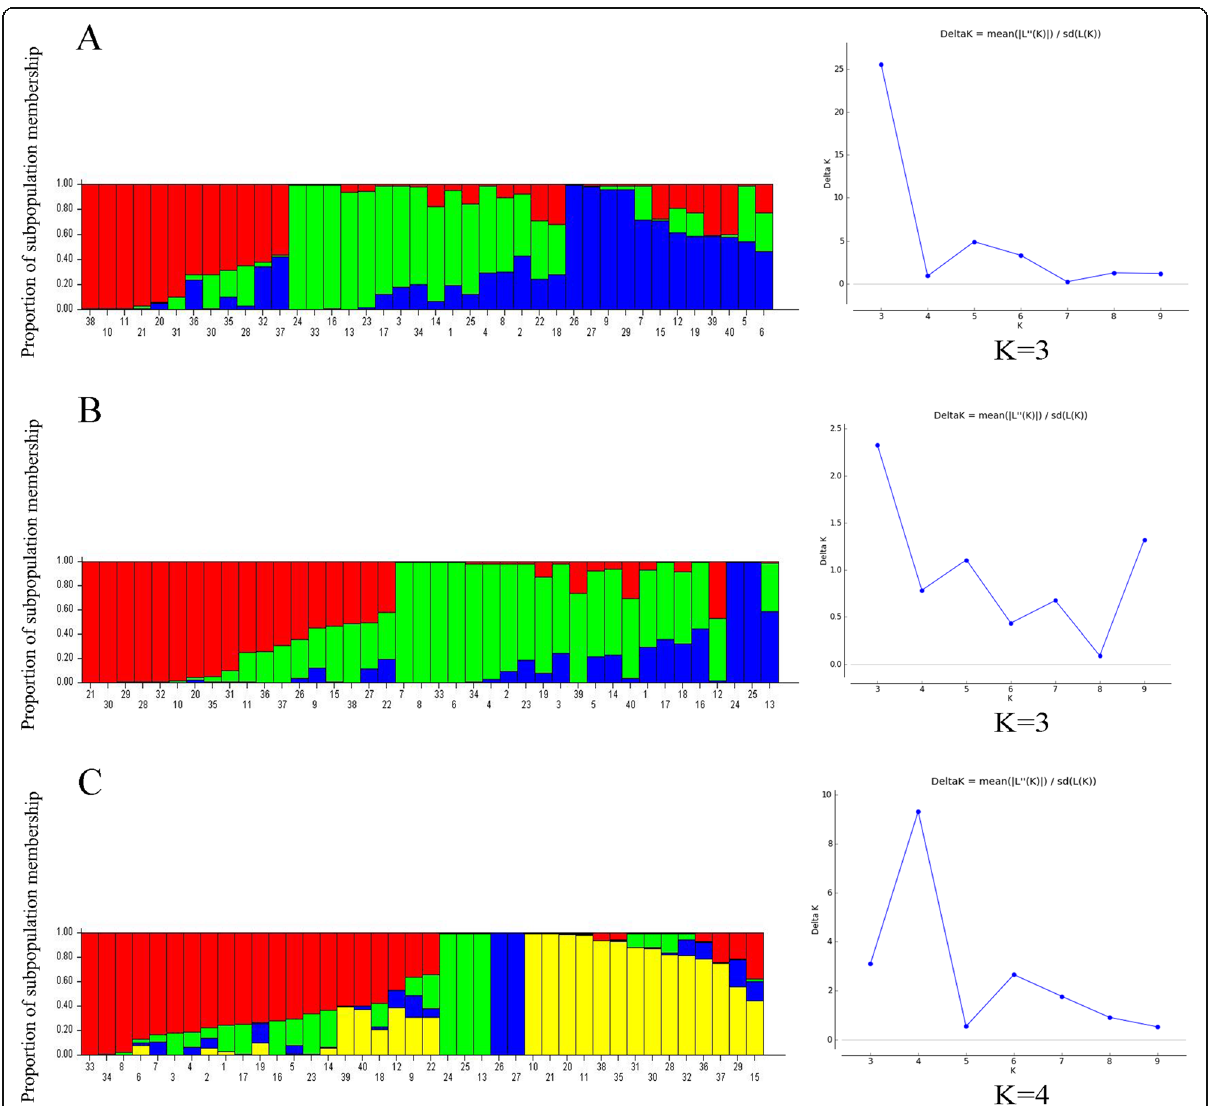
Fig. 4 Population structure of 40 R. damacena accessions based on URP (A panel), SCoT (B panel), and the combined data (C